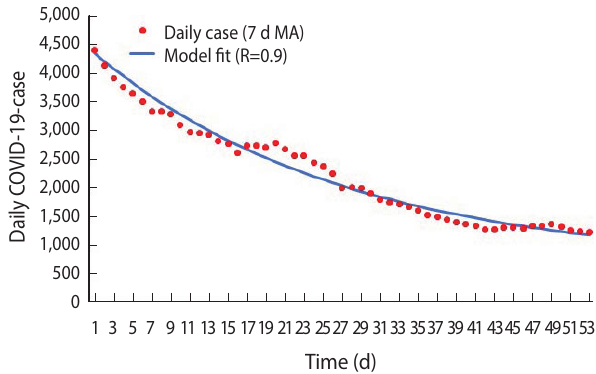
Figure 4. SEIR model fit for MCO with CMCO phase. SEIR, suscep- tible-ex posed-infected-recovered; MCO, movement control order; CMCO, conditional movement control order; COVID-19, coronavi- rus disease 2019; MA, moving